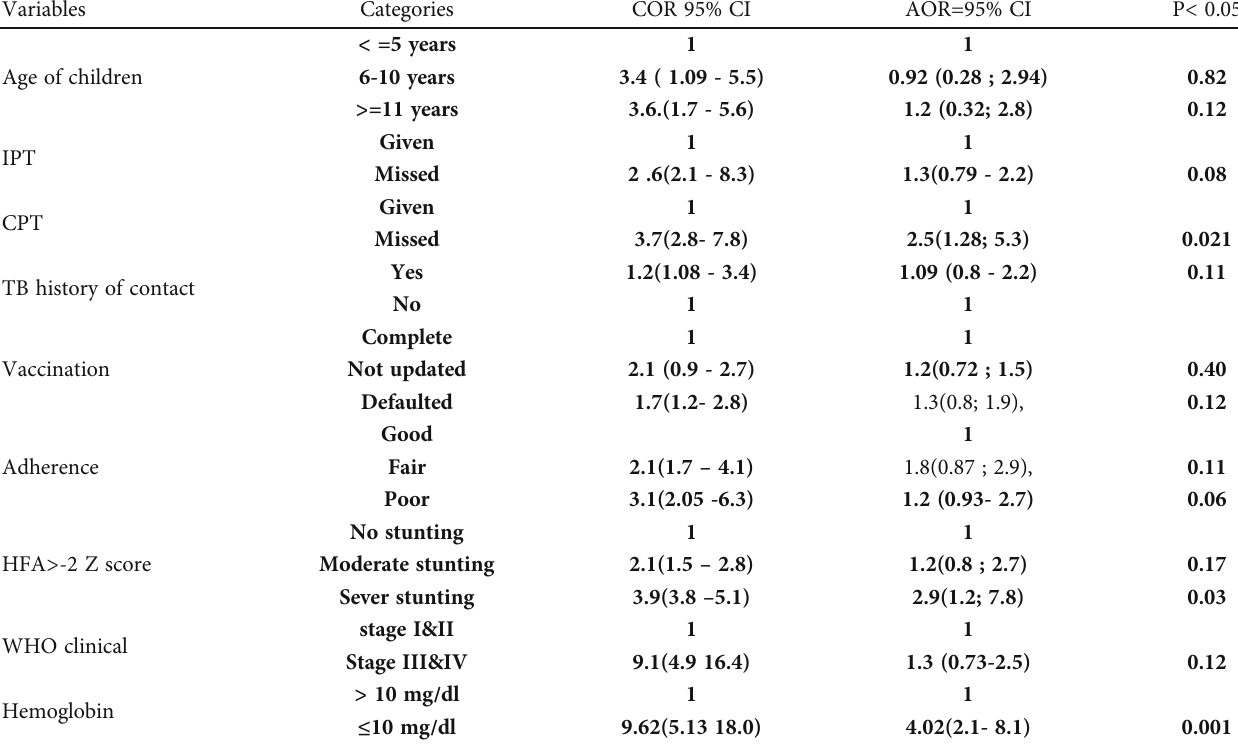
Table 4: Bi-variable and multivariable Cox-proportional hazard regression for predictors of TB among children treated on HIV/AIDS care in two public hospitals 2021 ( N = 421